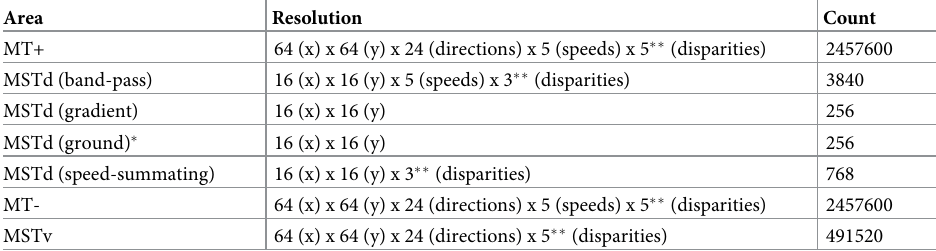
Table 1. Model unit counts within each area. � MSTd units tuned to ground patterns were added in Simulation 2. �� Disparity tuning was incorporated in Simulation 3.